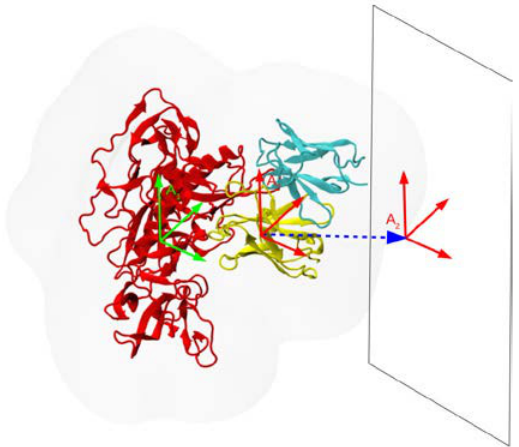
Figure 1. Schematic of the procedure used to compute PMFs of dissociation of Ab from the HIV gp120 Ag. Starting from the bound Ab/Ag complex, the Ab is displaced away from the Ag (red) along the vector (blue dashes) that points from the COM of the Ab in the direction that separates the Ag and the Ab (heavy chain is in yellow, light chain in cyan). Only the initial position of the Ab is shown. To preserve the relative orientations of Ag and Ab (indicated by the coordinate axes A 1 and A 2 ), weak harmonic restraints on the RMSDs of the Ag and Ab are applied, as described in the text. The rectangle perpendicular to the reaction coordinate indicates the orientation of the additional flat-bottom restraints to prevent excessive in-plane motion of the Ab, as described in the text. The faint gray outline indicates the solvent shell.